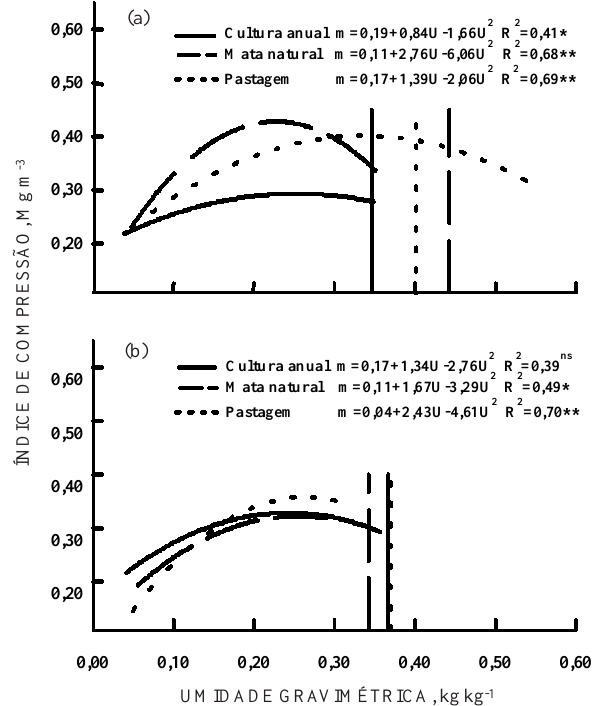
Figura 5. Relação entre o índice de compressão e a umidade gravimétrica para o Latossolo Vermelho- Escuro sob as condições de cultura anual, mata natural e pastagem, nas profundidades de 0-0,03 m (a) e 0,27-0,30 m (b), com n = 15 (as linhas verticais representam os respectivos limites de plasticidade, com três